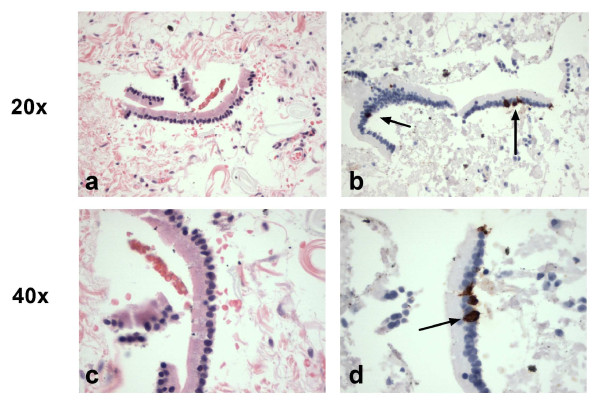
Examples of epithelial contamination of lymph nodes extracted with non-neuroendocrine malignancies, presumably caused during sample processing. These figures show small fragments of epithelium after H&E staining (4a and 4c) and matching epithelium in contiguous slides after Immunostaining for CgA (4b and 4d) in lymph node samples that exhibit PCR positivity. These tiny pieces of normal epithelium contain normal neuroendocrine cells (indicated by arrows) and therefore CgA transcripts are detectable. The top row is shown at 20x magnification and the lower row at 40x magnification.